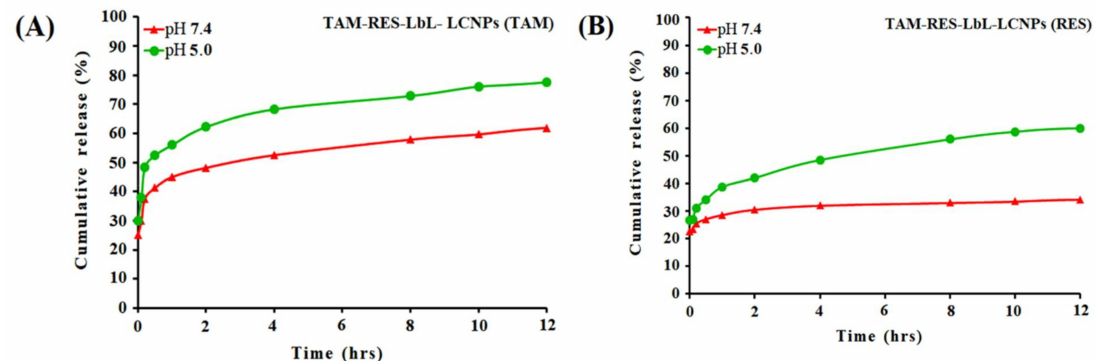
Figure 2. In vitro release profile of TAM–LbL-LCNPs ( A ) and RES–LbL-LCNPs ( B ) in PBS at pH 7.4 and pH